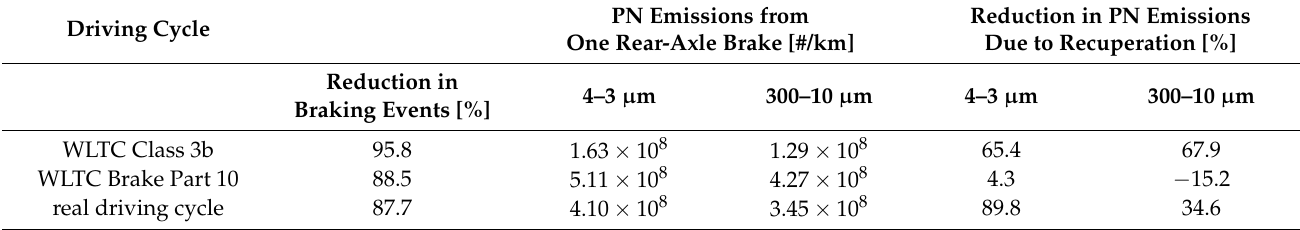
Table 2. Particle number emission indices for three driving cycles and particle number reduction due to recuperation. Ultrafine/fine particle emissions measured using a CPC for particle diameters between 4 nm and 3 µ m and coarse particle diameters between 300 nm and 10 µ m detected using an OPS.